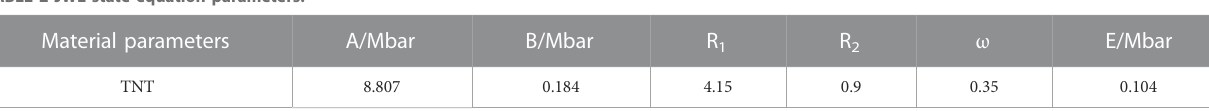
TABLE 2 JWL state equation